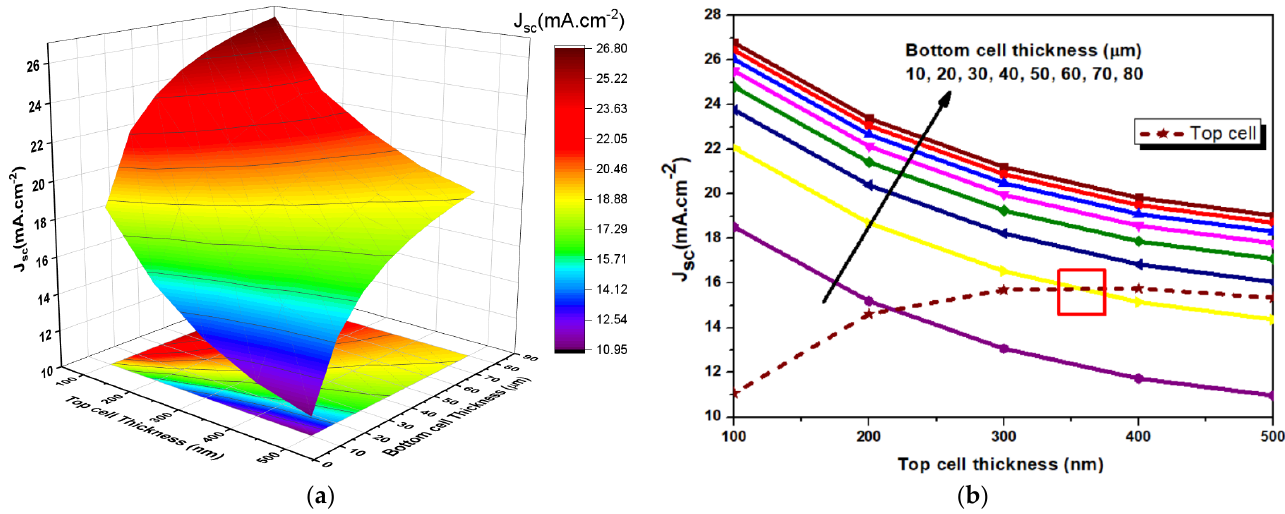
Figure 12. ( a ) The 3D contour plot of J sc of the tandem cell at different thicknesses of the absorber layers of both sub-cells. ( b ) J sc for top and bottom sub-cells as a function of both absorber thicknesses. The optimum pairing is highlighted by the red square.